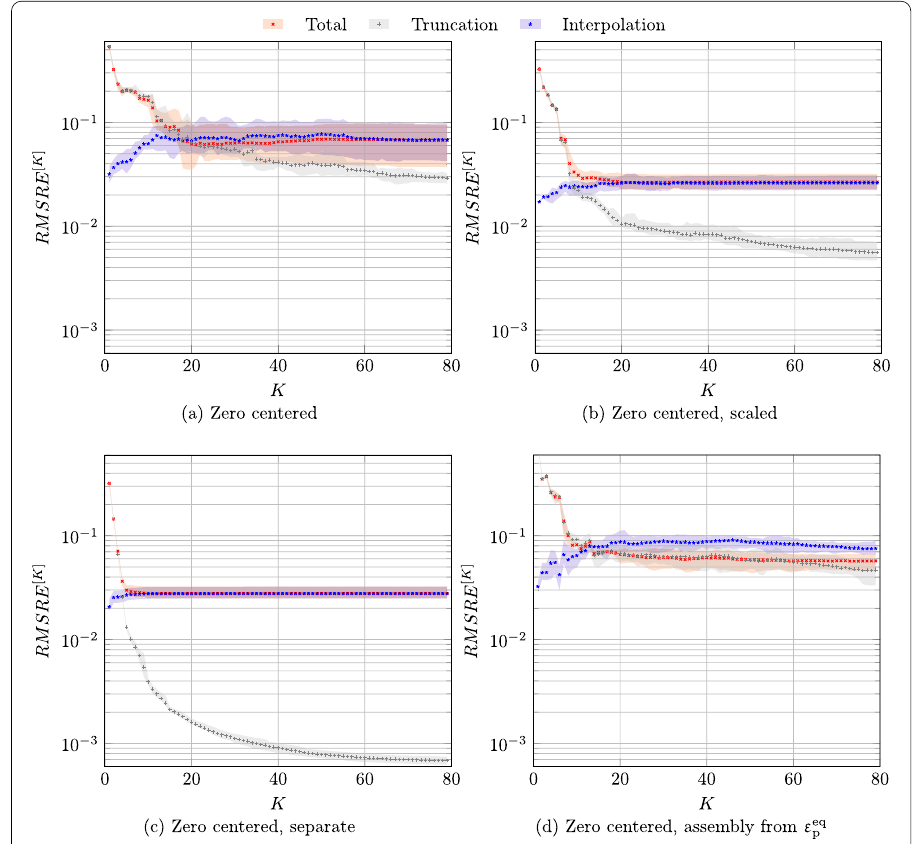
Fig. 10 RMSRE of the displacement field of the industrial bending problem using 4 different methods for surrogate model construction. The markers represents the mean over the 5 training sets. The shaded area represents the range over all training